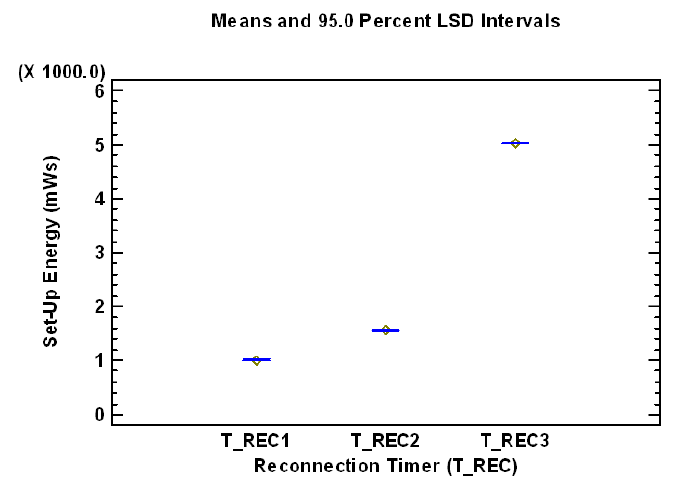
Figure 8. Mean values of the levels of the factor Reconnection Timer, analyzing the dependent variable Set-Up Energy (mWs).